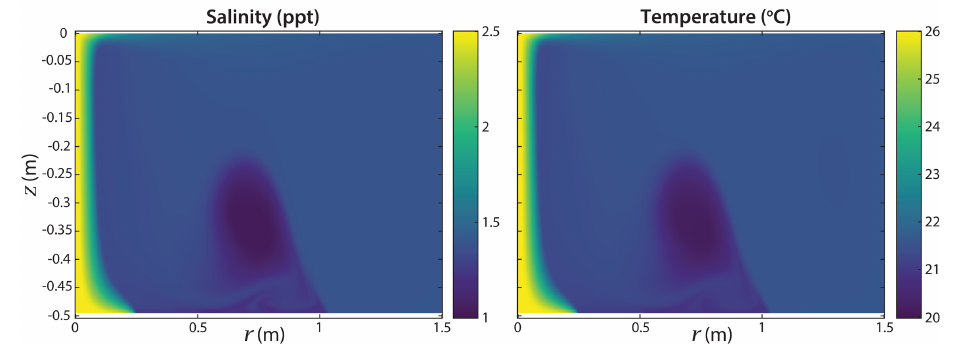
Figure 16. Unstable system (Case 7) with denser cold and fresh water on top of a warm and saline inflow ( t inflowing water flows upward through the centre independent of the inflow